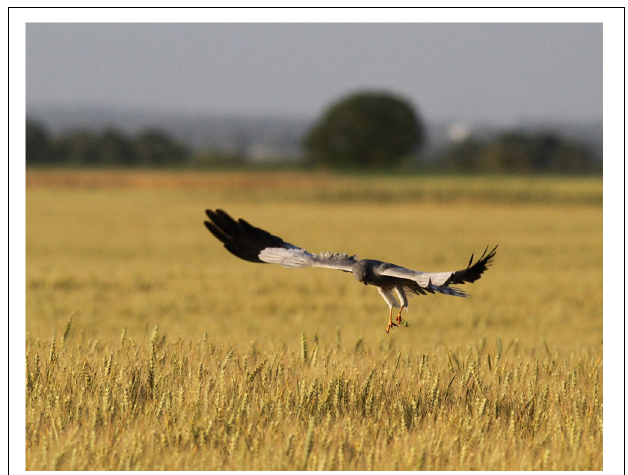
FIGURE 1 | Picture of a Montagu’s harrier ( Circus pygargus ) hunting a big green grasshopper in a wheat field in the Long Term Ecological Research Network site “Plaine et Val de Sèvre” (Photo: V. Bretagnolle). This shows that agricultural farmlands provide a suitable habitat for species other than the main crop, opening up new possibilities for resource and pest control by using the natural functions of farmland